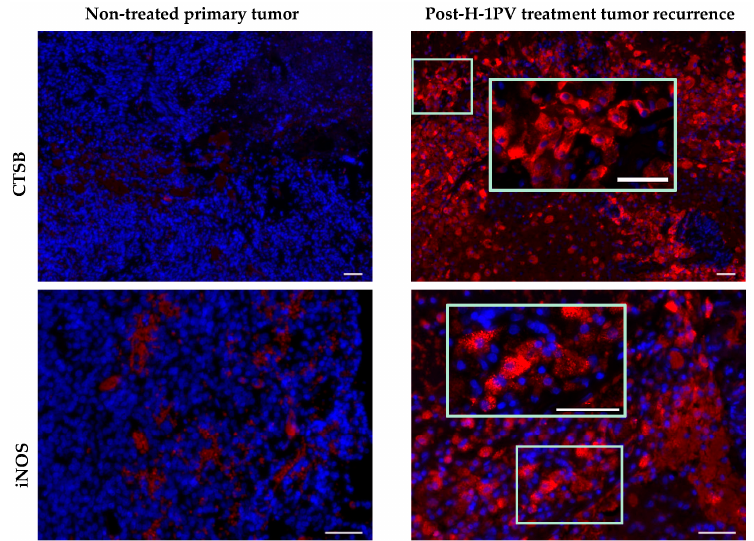
Figure 2. Comparative analysis of cathepsin B (CTSB) and inducible nitric oxide (NO) synthase (iNOS) expression in non-H-1 parvovirus (H-1PV)-treated primary tumor and in the second tumor recurrence (two months after H-1PV treatment of the first recurrence). CTSB, red; iNOS, red; DAPI, blue. Scale bars: 50 μ m.